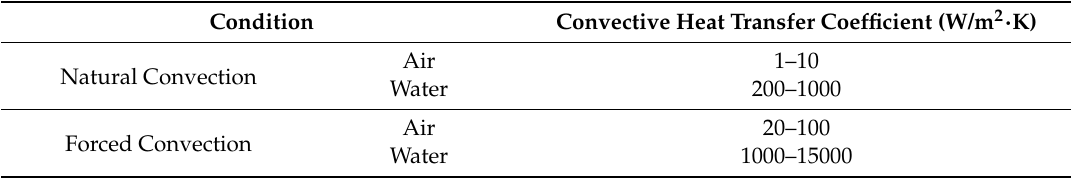
Table 2. Convective Heat Transfer Coefficient of Air and Water under natural and forced convection.